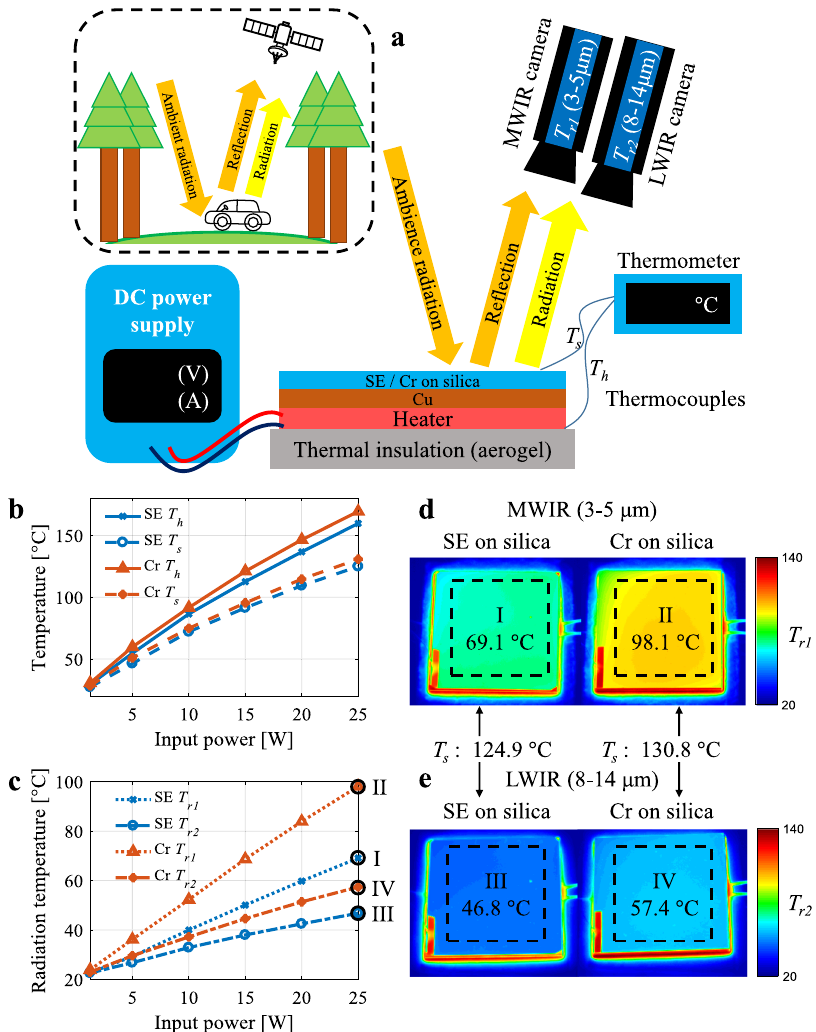
Fig. 3 IR camou fl age demonstration. a Schematic diagram of the experimental con fi guration for IR camou fl age and radiative cooling performance demonstration. b Measured heater/surface temperature T h / T s for SE and Cr at different input heating power values. c Measured radiation temperature T r1 / T r2 in MWIR/LWIR band for SE and Cr at different input power values. d IR images of SE and Cr at 25 W input power captured by MWIR band thermal imager. e IR images of SE and Cr at 25 W captured by LWIR band thermal